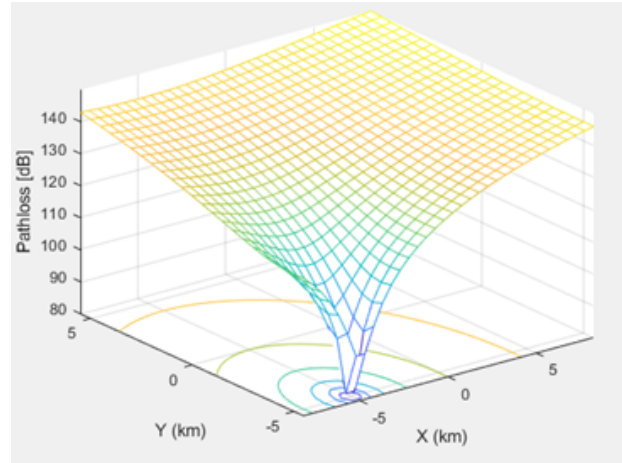
Figure 21. Path loss in the urban scenario, BS No.